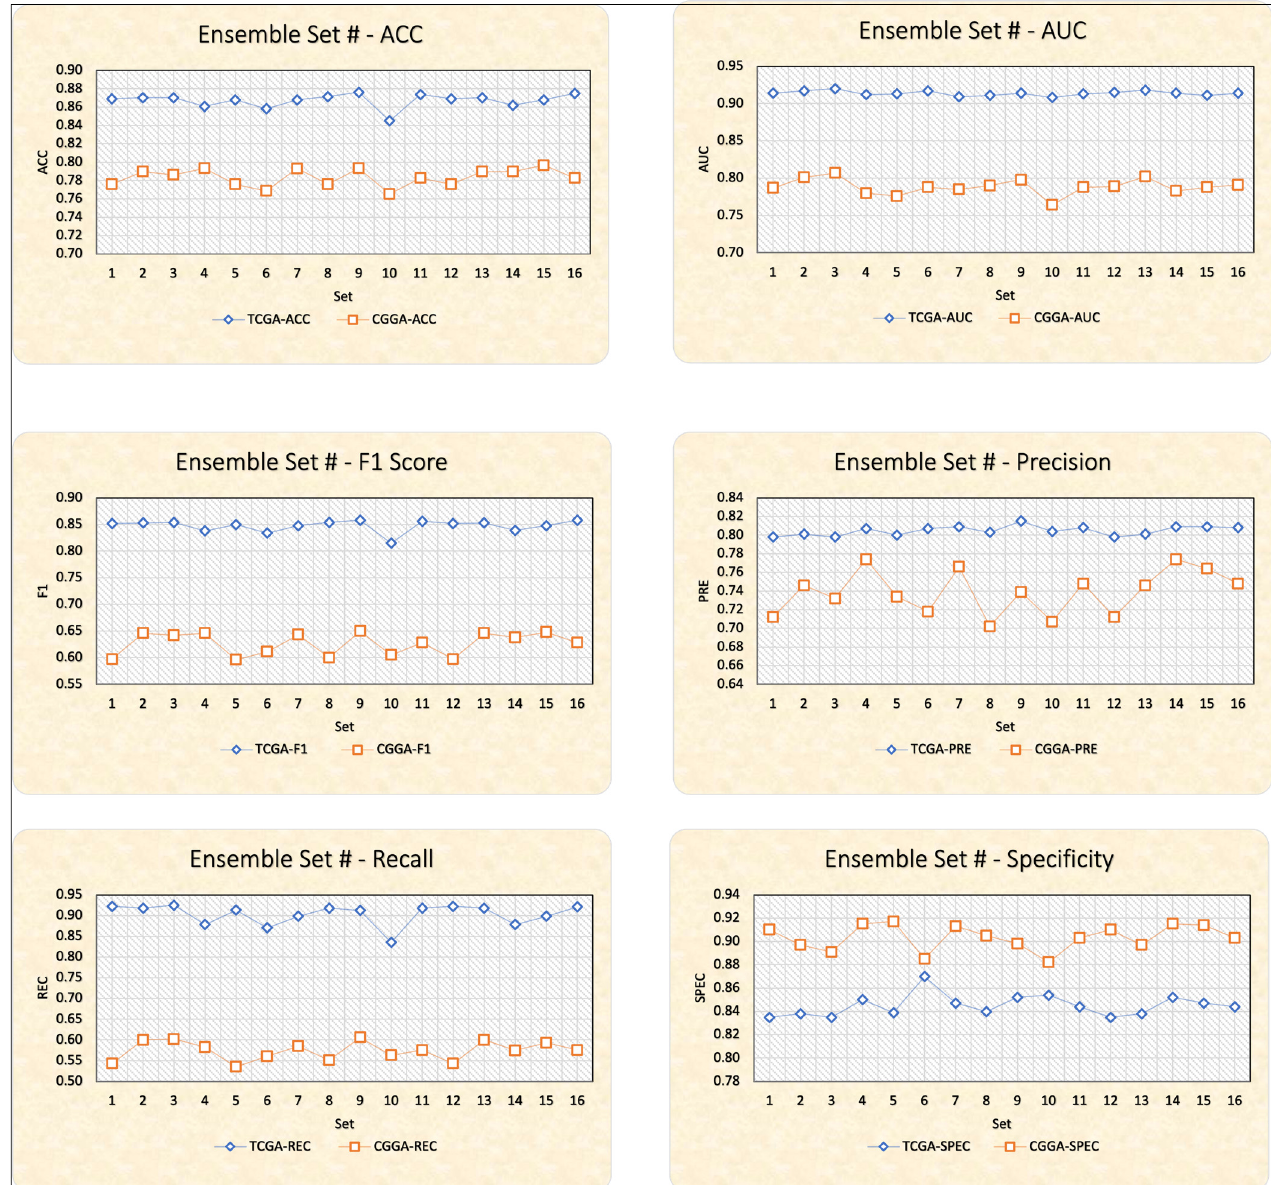
Figure 2. Graphical representations of the computational results for the TCGA and CGGA datasets. Table 6. The computational results without the feature selection process for the best ensemble set.